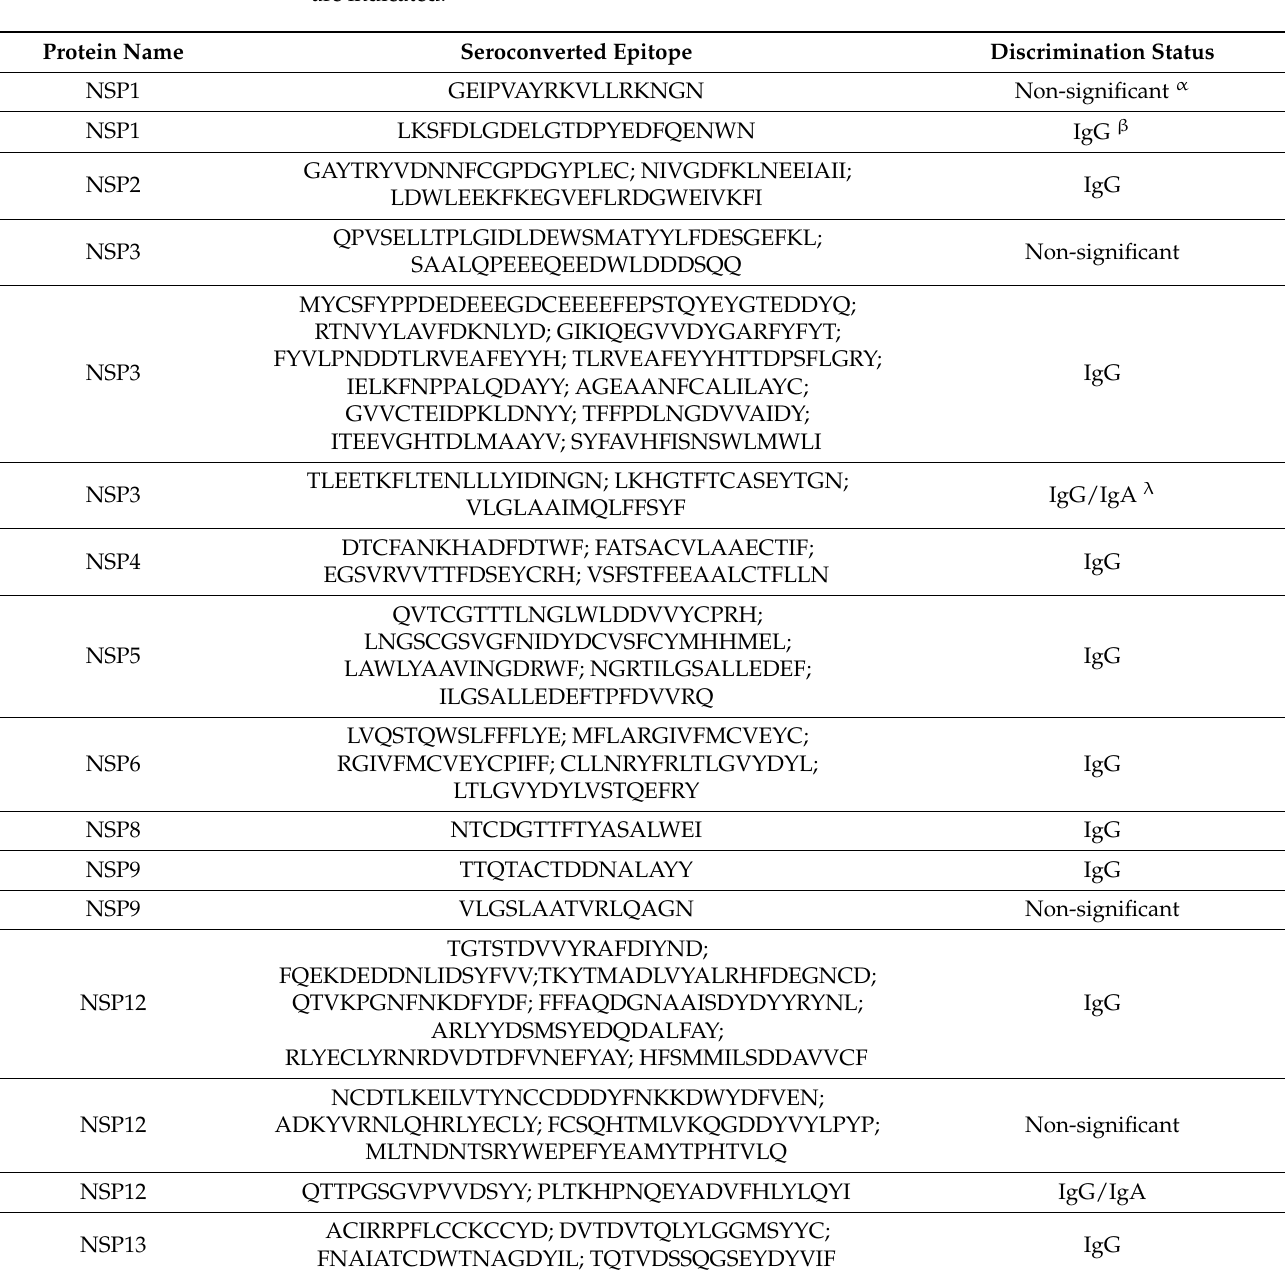
Table 1. Viral protein-wise list of epitopes that seroconverted from IgA to IgG in patients. The IgA/IgG epitopes that could discriminate between severe and non-severe forms of the disease are